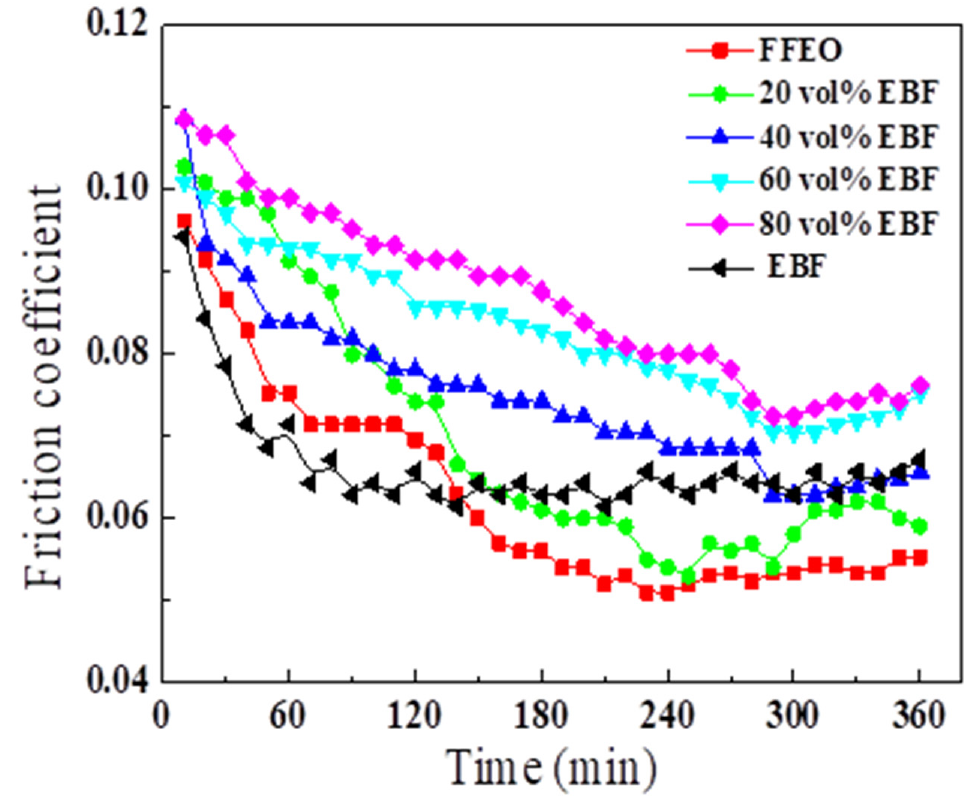
Figure 2. Variations in friction coefficient for various oil samples at a load of 210 N and a reciprocating frequency of 10 Hz.